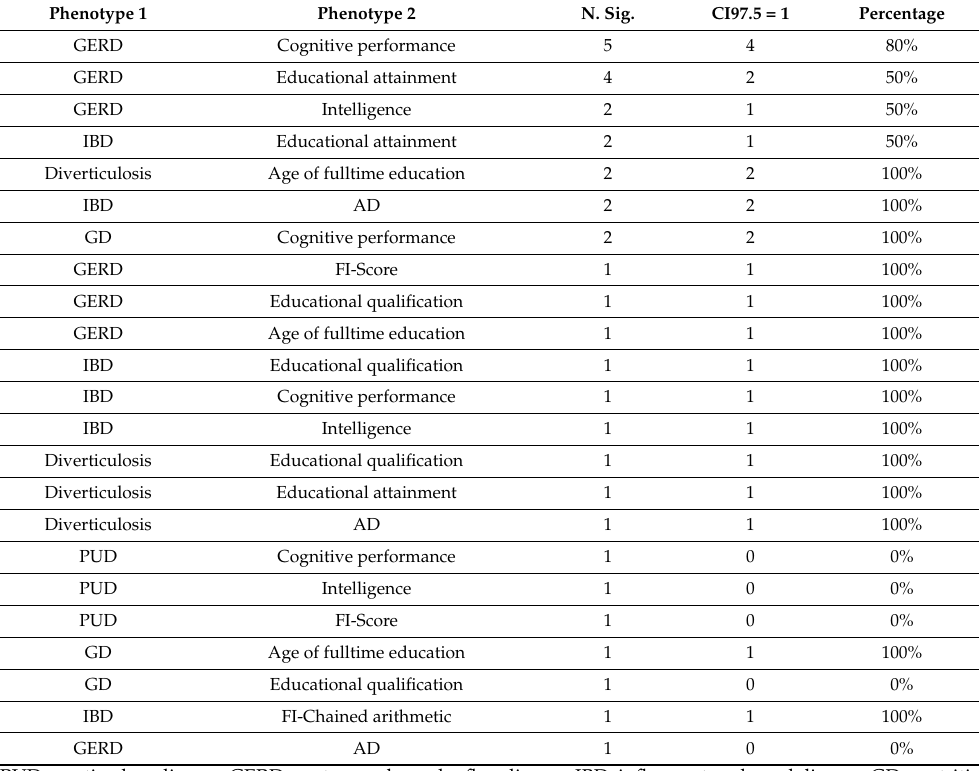
Table 3. Overview of significant bivariate local correlations and